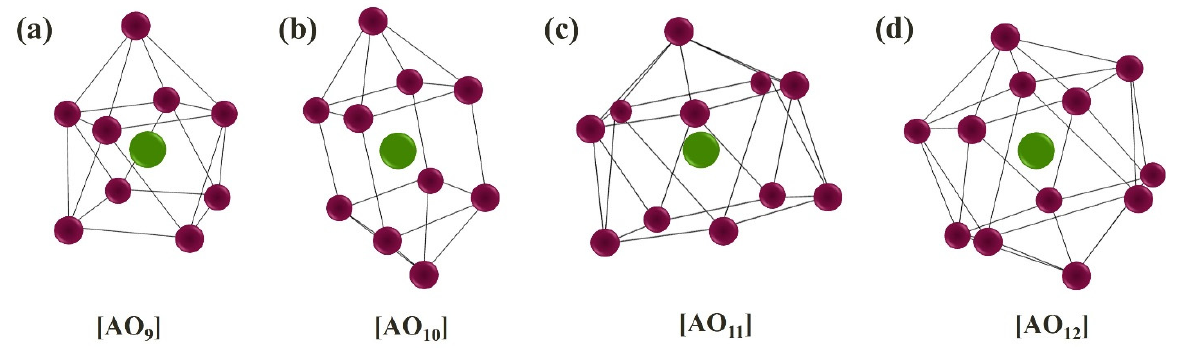
Figure 3. Representation of oxygen polyhedra (red spheres) with different coordination number of central atom (green sphere).